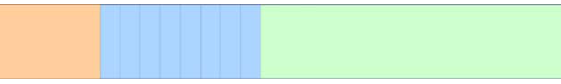
Figure 5. Axial breeding blanket of the BBMSR. Figure 6. Axial blanket.